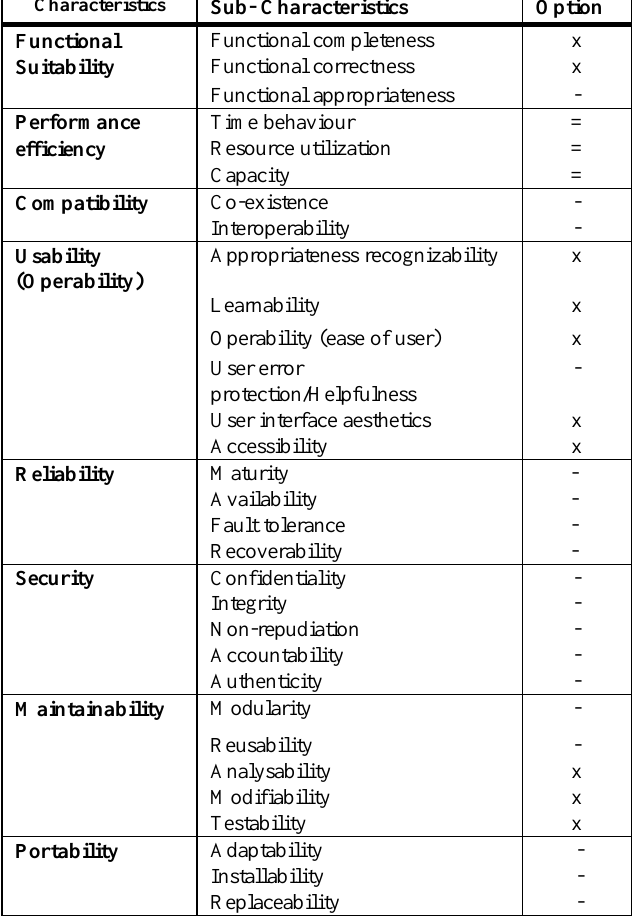
Table 3. Customized software quality model [ISO/IEC